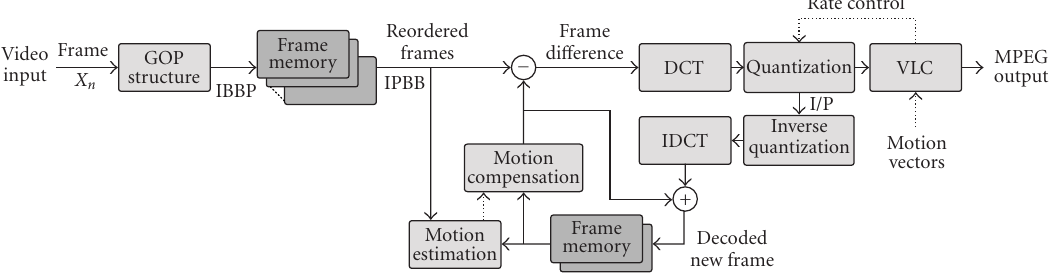
Figure 3: Basic architecture of an MPEG